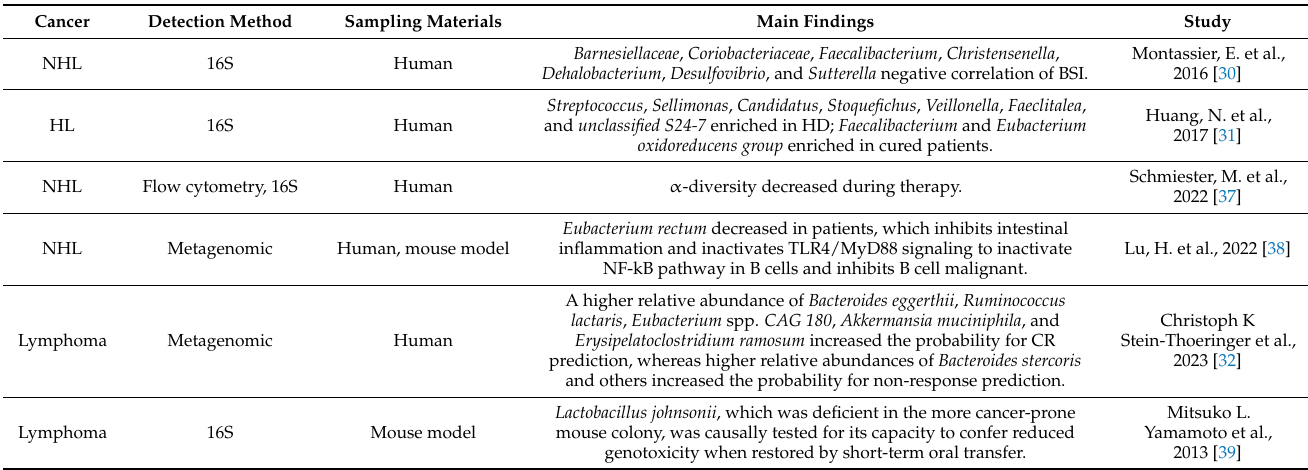
Table 2. Relationship between intestinal microbes and